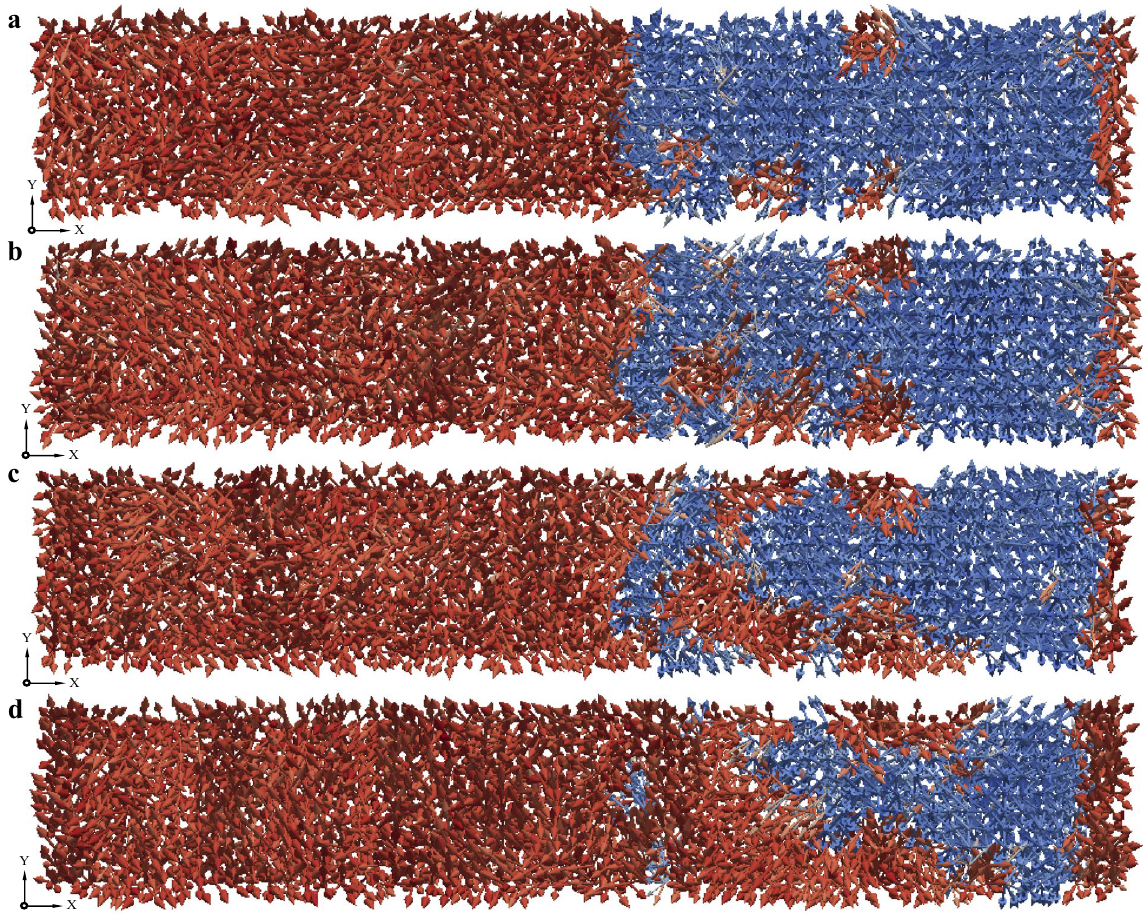
Figure 4. Domain pattern revealing nucleation of new domains. ( a ) At t = 4.8 ps nucleation of new domains inside reversal domain are observed under the field of 30 MV/m. ( b and c ) Domain patterns at t = 6.2 ps and t = 7.2 ps reveal that the nucleated domains grow in size ( d ), at t = 8.2 ps show that the some of the nucleated domains merge into nearby growing domain. After around t = 15.3 ps the system has completely switched which is not illustrated in the